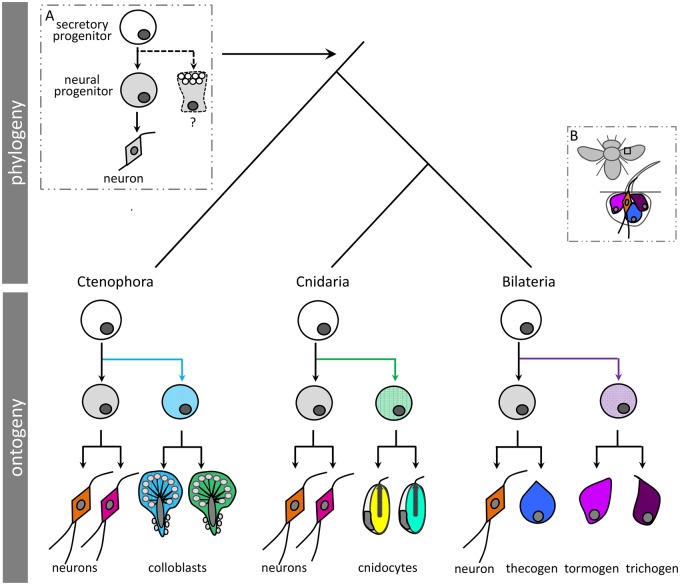
A possible scenario for the origin of secretory cell diversity in animals. (A) The common ancestor to ctenophores, cnidarians, and bilaterians may have already had a secretory cell progenitor (white) giving rise to neurons and some other unspecialized secretory cell. This pathway may have been independently co-opted (colored lines) to give rise to novel secretory cell types in ctenophores, cnidarians, and bilaterians. (B) The common origin of the neural and secretory cells responsible for making the sensory apparatus in flies supports this hypothesis in bilaterians. Sponges and placozoans have been excluded for simplicity.